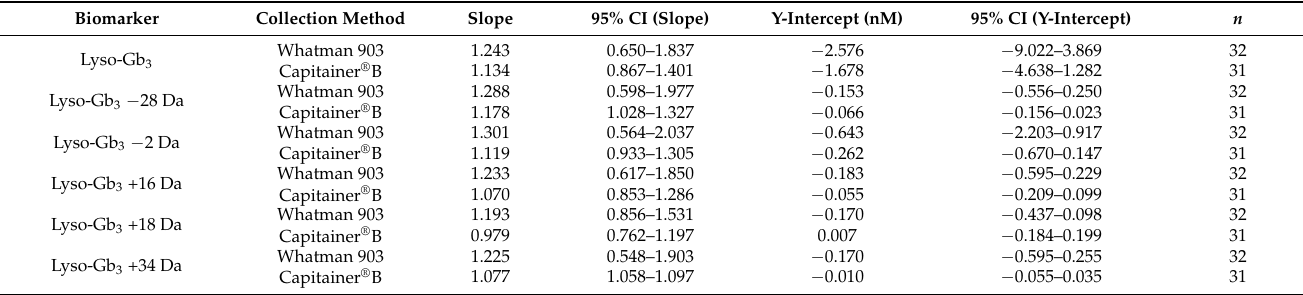
Table 11. Deming regression analysis parameters for lyso-Gb 3 and analogue measurements in venous and capillary blood.